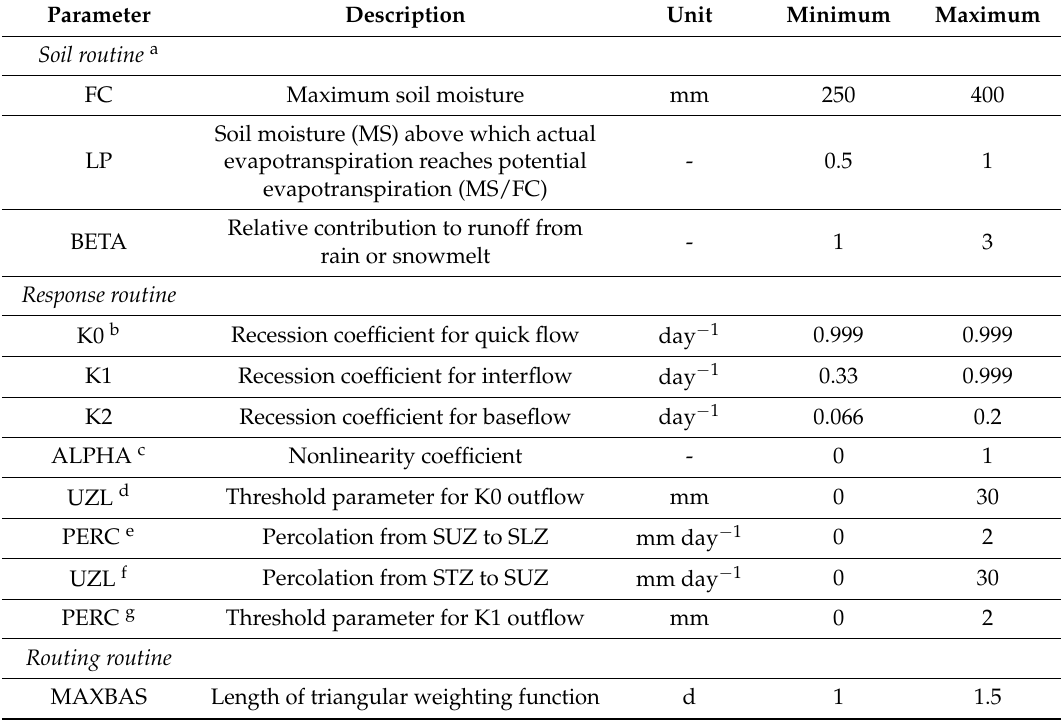
Table 3. HBV-light model parameters and their range used in the Monte Carlo